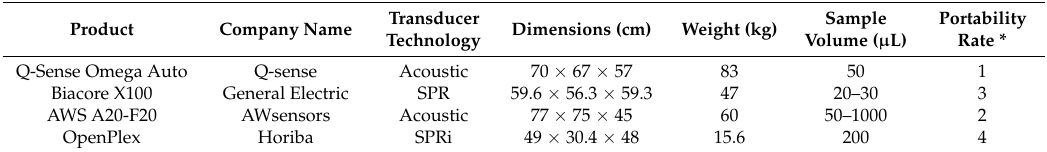
Table 3. Different commercial biosensing systems currently available on the